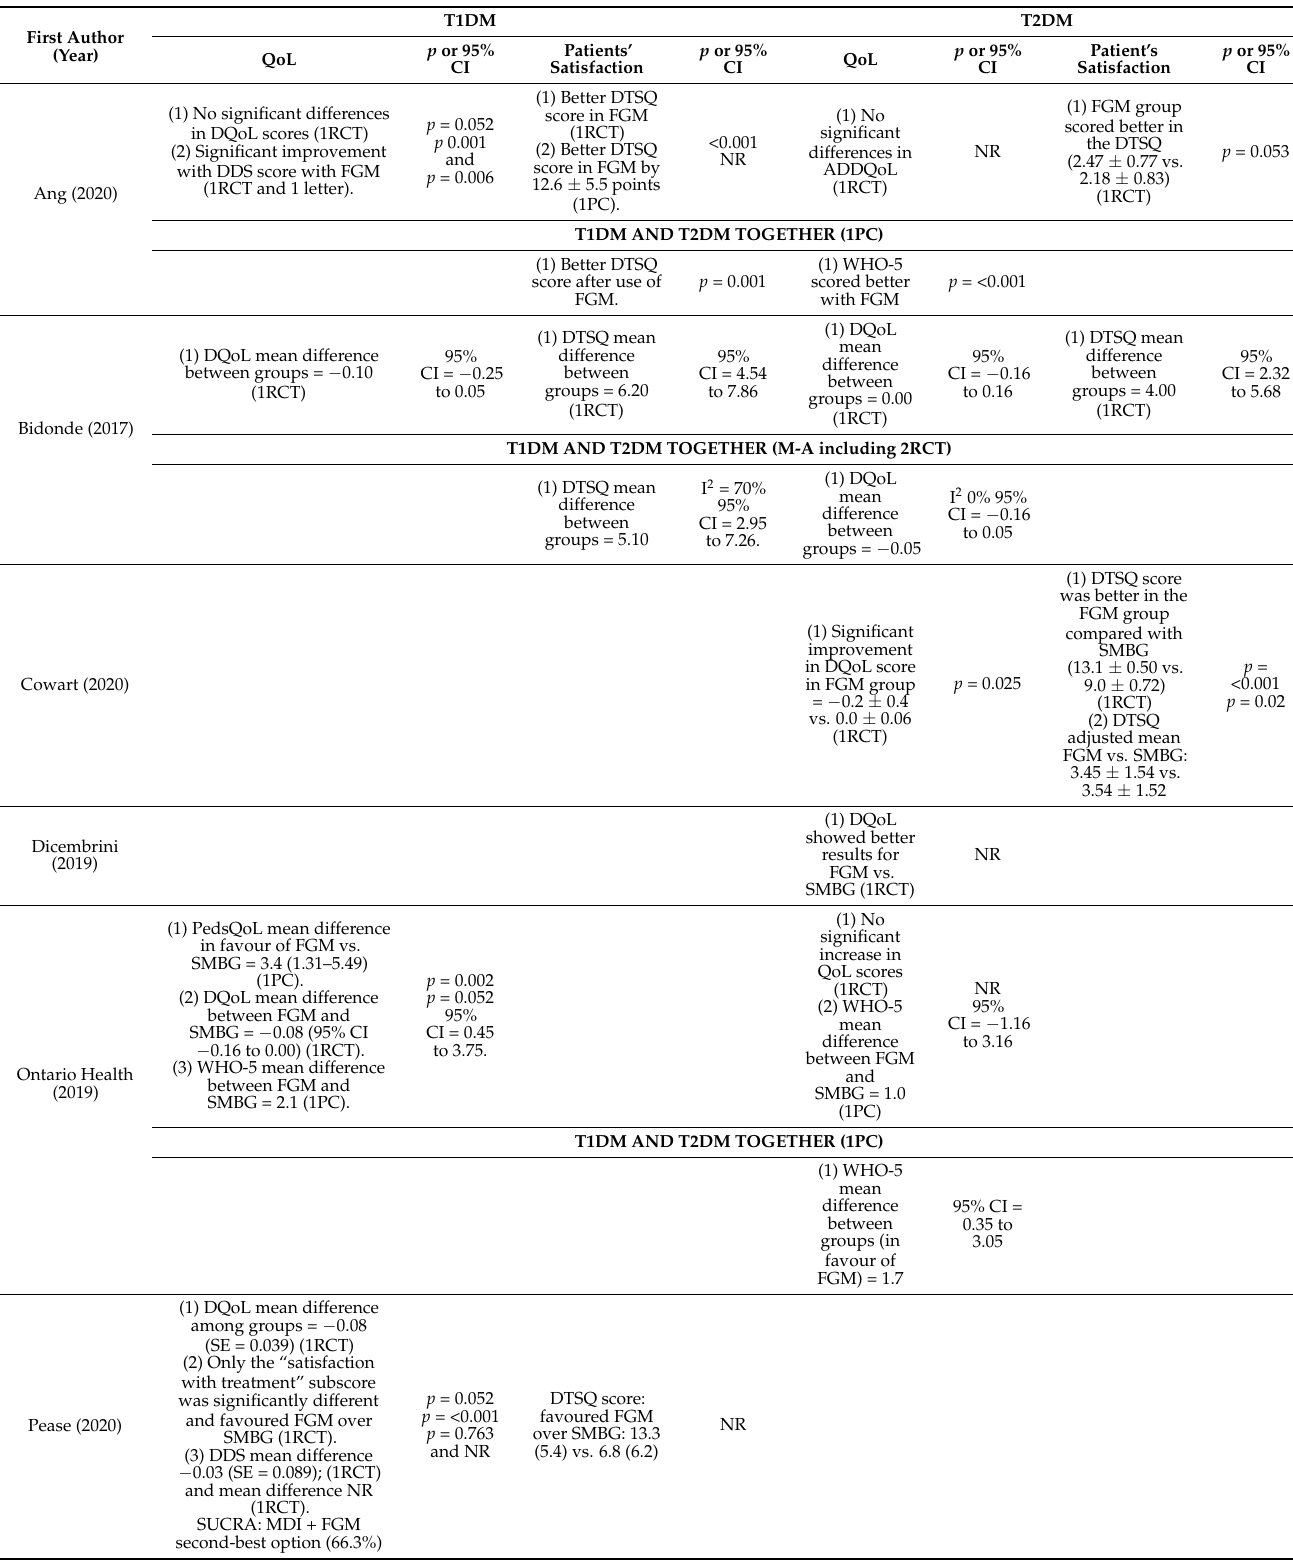
Table 4. Quantitative results showed in the included systematic reviews and meta-analysis between FGM and